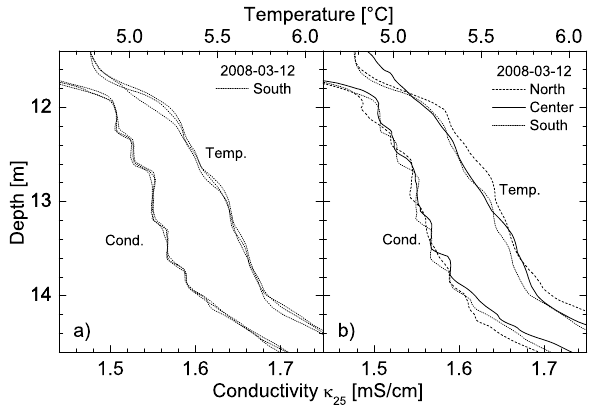
Fig. 6. CTD-profiles from three different sites at Lake Moritzteich (section of double diffusive zone in the upper part of the moni- molimnion) Panel (a) : Consecutively taken profiles to verify the re- producibility of single measurements. Panel (b) : Profiles from three different measurement sites to illustrate horizontal